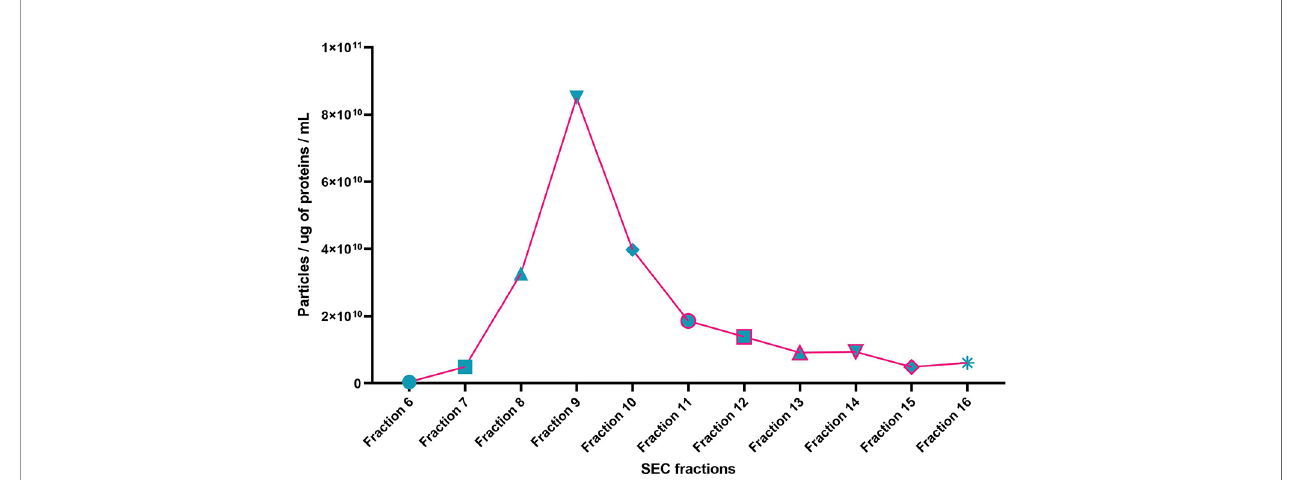
FIGURE 2 | Particle size distribution per total protein for SEC fractions 6 – 16 of a representative sample (NTA particles per mL / total protein (µg/mL). Particle per ug of protein per